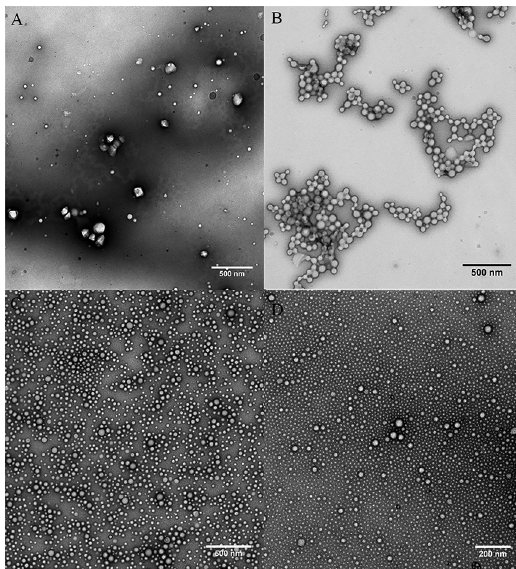
Figure 3: Transmission electron micrographs of the nanoparticles after filtration through 0.45 μm membranes and their histograms for: (A) PEO - b -PLA ; (B) PEO - b -PLA containing 10% 5KDa 4.5KDa 5KDa 4.5KDa lavender essential oil; (C) PEO